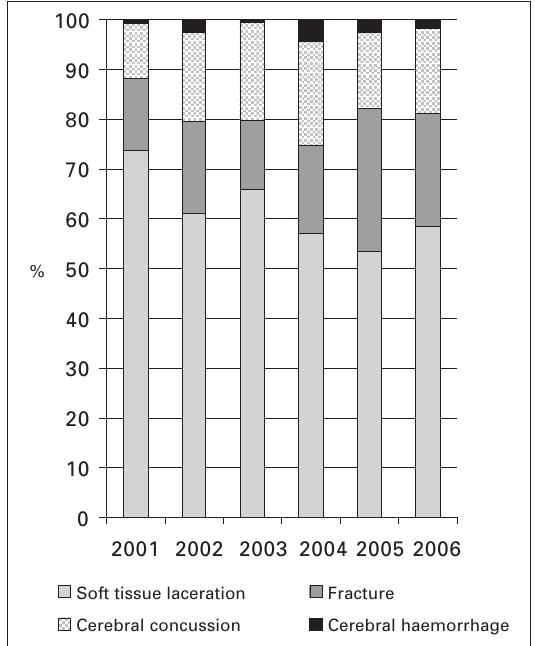
Type of head injury [ % ].